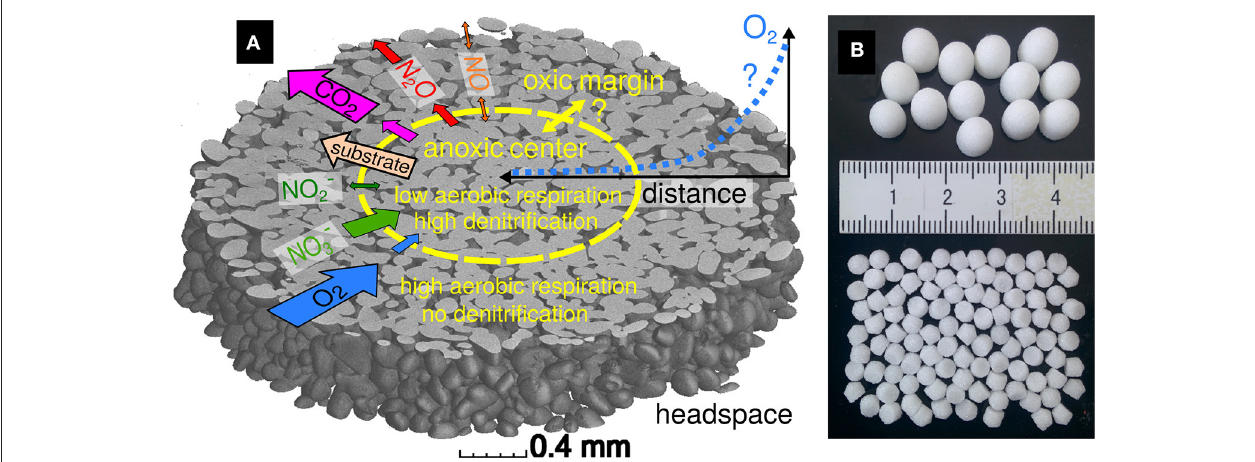
FIGURE 1 | (A) An anoxic aggregate center of variable extent is expected to form during incubation. Here it is depicted within a subvolume of a 3.5mm aggregate scanned with X-ray microtomography, showing the grains in gray while the liquid-filled pore space is transparent. Arrows are drawn proportionally to the expected fluxes between the headspace, aggregate margin and center. Precursor substances of aerobic respiration and denitrification (substrate, O 2 , NO − 3 ) as well as final products (CO 2 , N 2 O) are drawn as one-sided arrows, whereas intermediate substances may diffuse in any direction depending on concentration gradients. (B) Two different aggregate sizes (3.5 and 7mm diameter) were used for incubation. Identical fluid volumes (0.83ml) were used during incubation by adjusting the number of inoculated aggregates per bottle (100 and